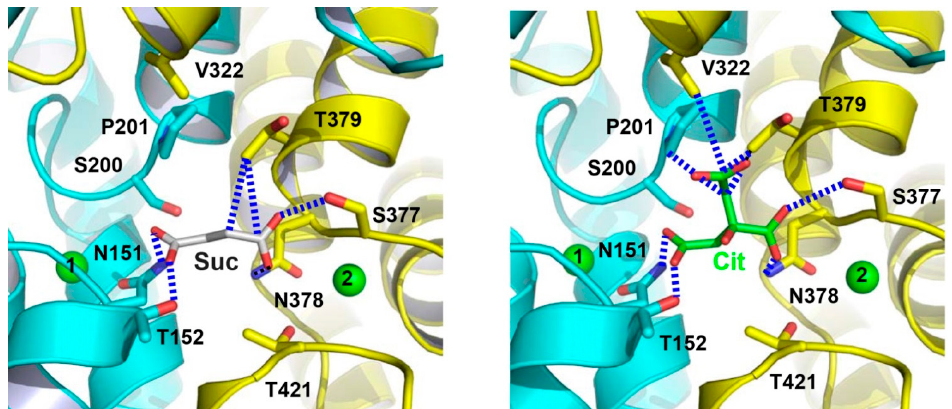
Figure 5. Close-up views of the succinate- and citrate-binding sites in VcINDY. Structure of the succinate-binding site ( left panel ). Detailed view of the citrate-binding site ( right panel ). Succinate (grey), citrate (green) and relevant amino acids are drawn as stick models, whereas the Na + ions are shown as green spheres. Dashed lines (blue) highlight the interactions between VcINDY and succinate or citrate.